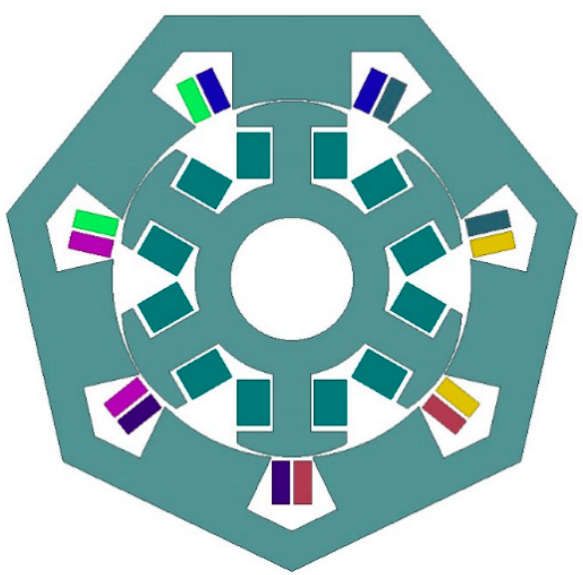
Figure 3. 2D structure of 7-phases/7-slots/6-poles heptagonal based WRSM.